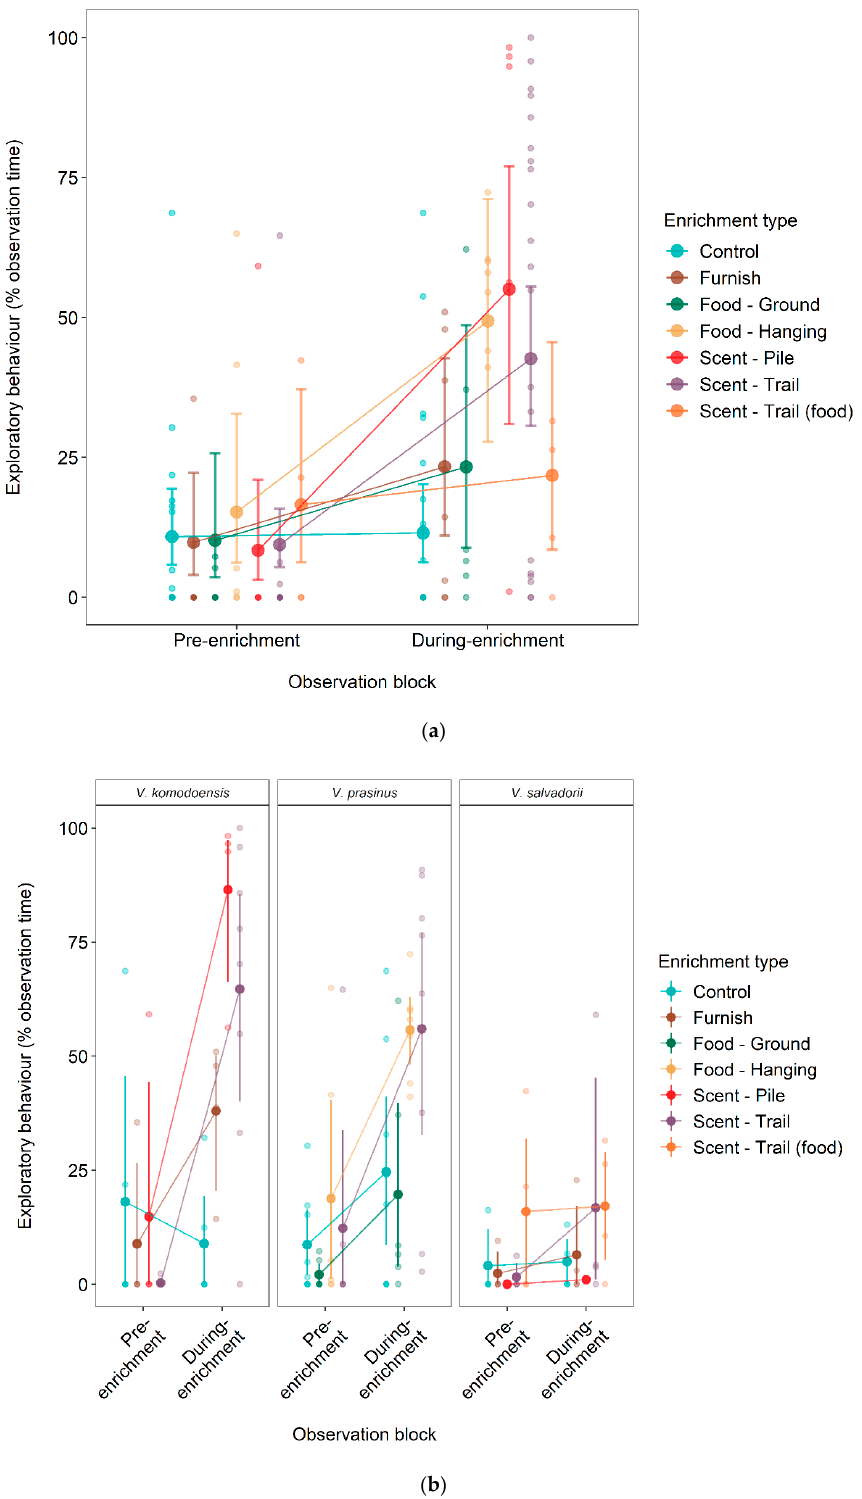
Figure 1. ( a ) Effect of enrichment provision on exploratory behaviour in three varanid lizard species. Large points and error bars represent predicted means ± standard error from a Beta GLMM. Small points represent individual trials (raw data). ( b ) Species-specific effect of enrichment provision on exploratory behaviour in three varanid lizard species. Large points and error bars represent raw data means and 95% non-parametric bootstrap (10,000 samples) confidence intervals. Small points represent individual trials (raw